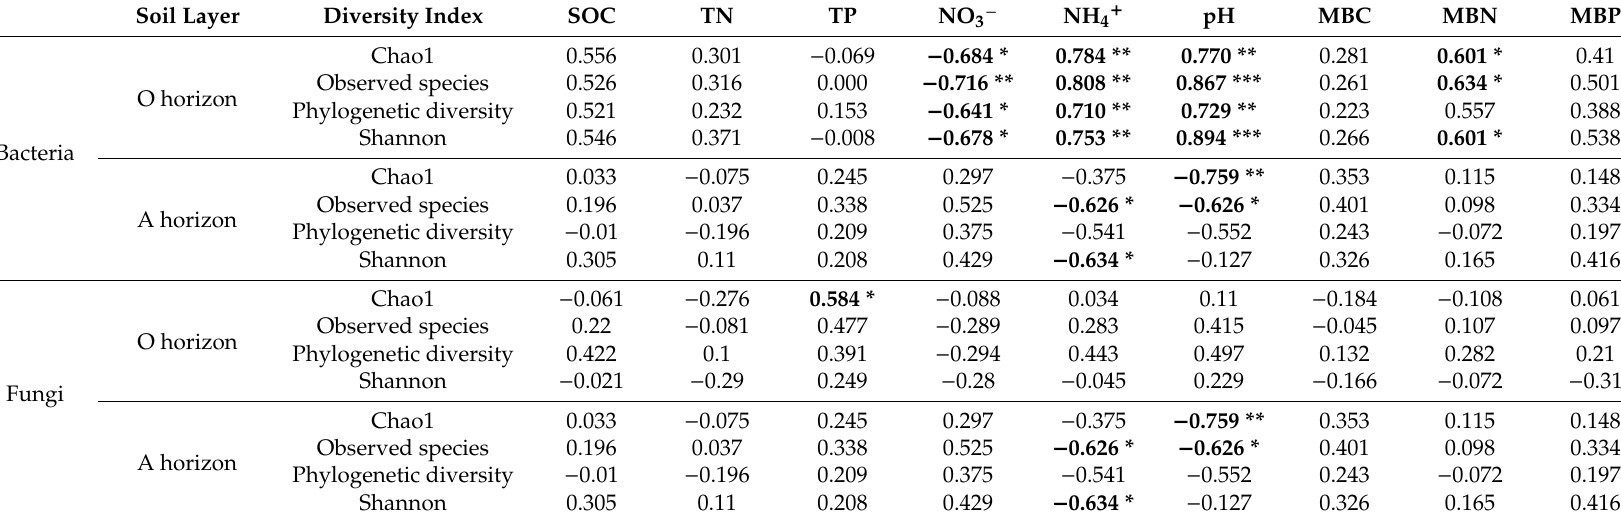
Table 1. The pairwise correlation analysis between soil microbial diversity index (Chao1, Observed species, Phylogenetic diversity and Shannon) and soil properties. Values in bold indicate significant correlations. * p < 0.05, ** p < 0.01 and *** p <